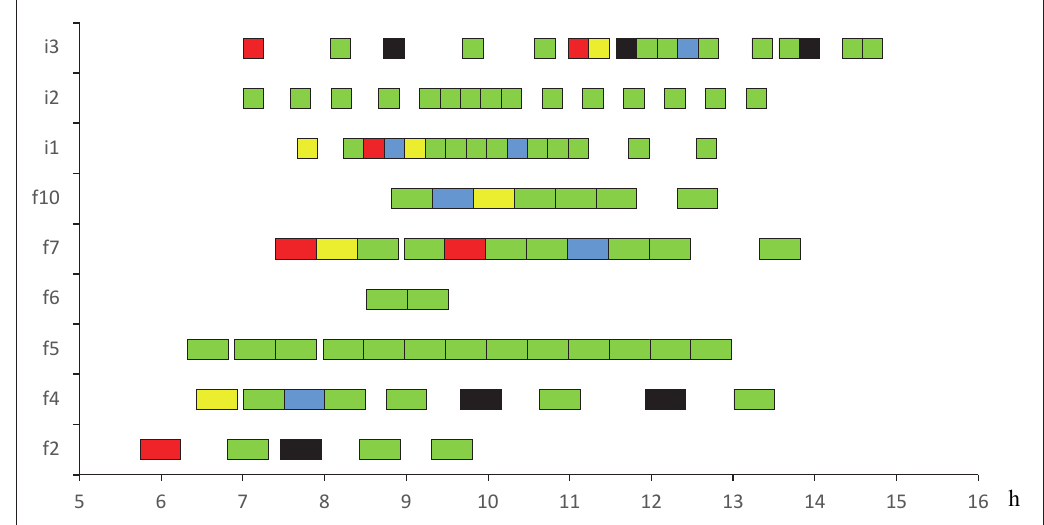
Fig. 4. Loading times at harvest areas and unloading times at